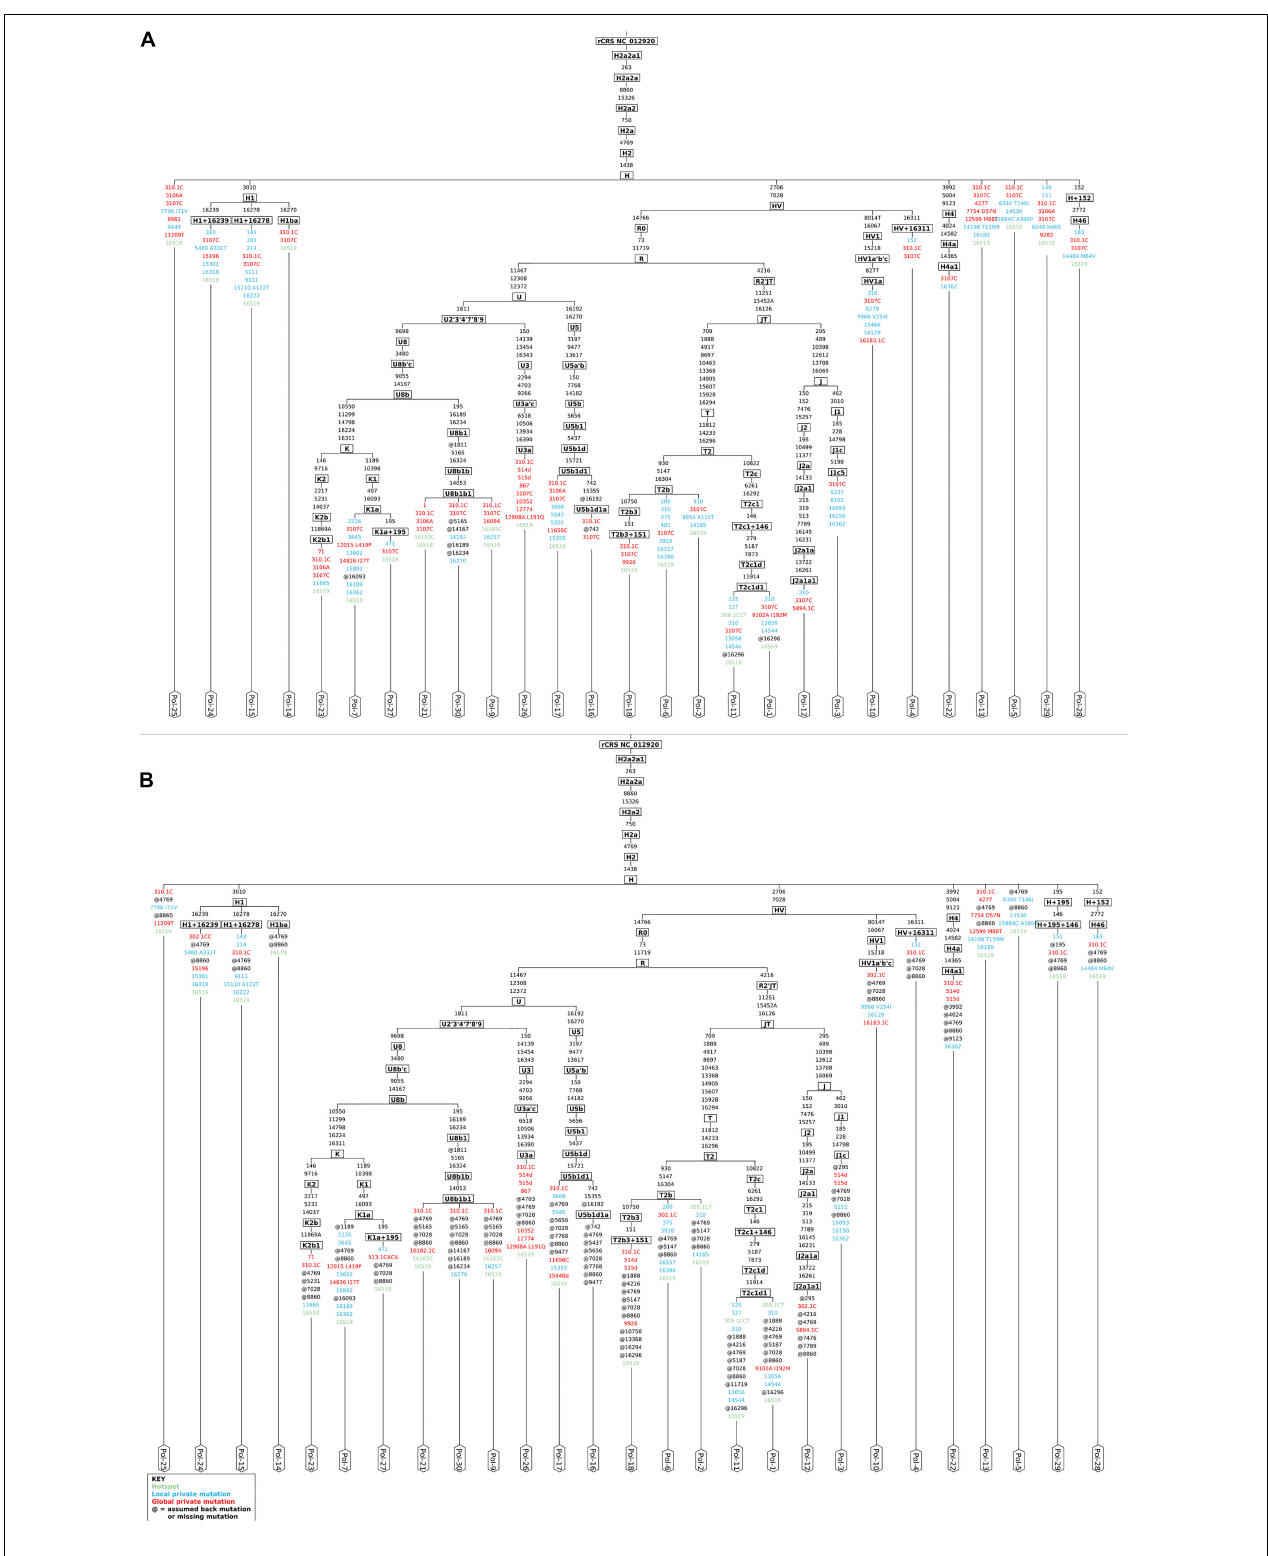
FIGURE 2 | Mitochondrial phylogenetic trees from Polizzello sequences. Phylogenetic trees of mitochondrial DNA variation in Polizzello samples were obtained by Haplogrep2 from consensus sequences generated by schmutzi (A) and those obtained from variants called by Mutect2 and retained after filtering based on allele depth ( ≥ 10) and allele fraction ( ≥ 50%) and considering the highest contamination rate (2%) (B) . Slightly different haplogroups were predicted for three samples (Pol-3, Pol-10, Pol-29). Amino acid changes are shown for non-synonymous variants.